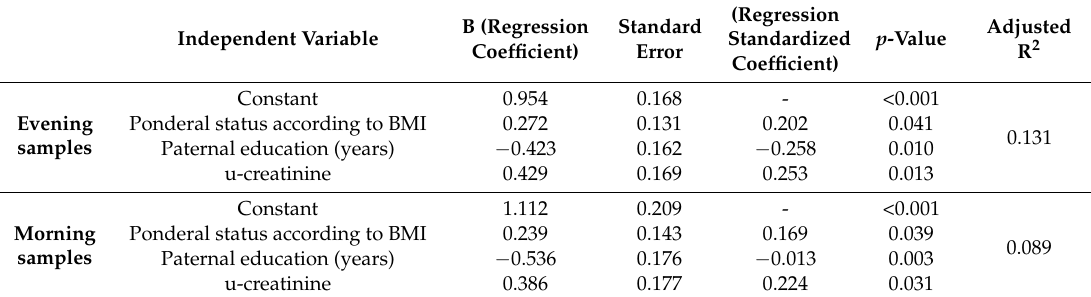
Table 8. Significant predictors of the urinary (u-) concentration of cotinine expressed as µ g L − 1 (independently for evening and morning urine samples) in children exposed to